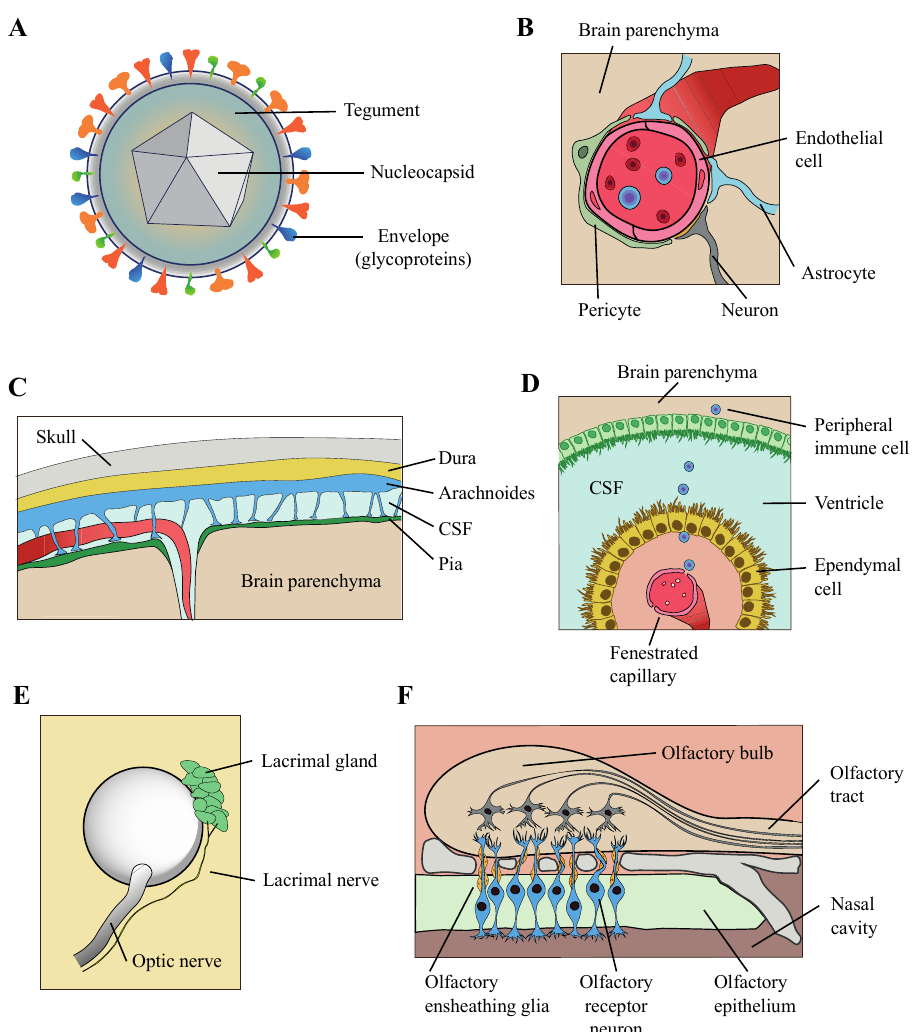
Figure 3. Schematic representation of HHV-6 virion structure ( A ) and suggested HHV-6 entry routes to the brain parenchyma: ( B ) The blood–brain barrier; ( C ) the meningeal barrier; ( D ) the blood–CSF barrier at the choroid plexus; ( E ) optic infection through lacrimal or optic nerves, and ( F ) the olfactory pathway. CSF: Cerebrospinal fluid.